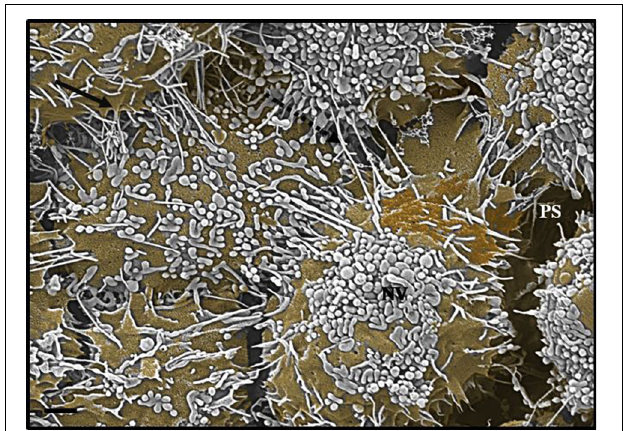
FIGURE 7 | Hemifusion across the PC space between two juxtaposing BECs (Scale bar = 1,000 nm). The HRSEM micrograph depicts juxtapositioning adjacent b.End5 cell membranes and subsequent TJ protein alignment facilitated by TUNT and TENT formation denoted as “ TU ” and “ TE ” within 24 h of monolayer establishment. The occurrence of TENTs and TUNTs together is a clear observation that they have distinctly different functions. The “ white circles ” highlight the extremities of the TENT structures which exhibit bulb-like distal ends. The “ gray circles ” highlight the proximal ends of TENTs, which form tent-like leaflets from the leading edges of the cell membrane. The “ black circles ” highlight the distal ends of TUNTs, which fuse with the surface membrane of the adjacent/target cell, the lower black circle illustrates the short fibers tethering the foot process to the membrane. The “ white arrows ” indicates an additional, novel feature that presents itself throughout the BEC cultures as a partial “stitching” together of adjacent BECs across the PC space (partial fusion). This hemifusion of adjacent BEC cell membranes indicates the site for TJ protein interaction and the “ red circle ” illustrates the beginning of membrane overlapping. The C* denotes cell one and the C $ denotes cell two (the target